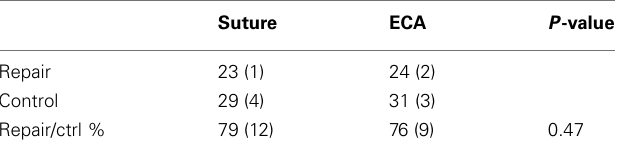
Table 3 | Mean (SD) morphometric data on the degree of intensity of synaptophysin-labeled profiles in contact with RLMs in the lateral ventral horn of the L5 spinal cord 6months after transection and repair of the left rat sciatic nerve with either ECA or epineurial sutures.The ratio occupied by the labeled structure of interest was estimated as the percentage (%) of the repaired versus the control side ( n = 6 in each